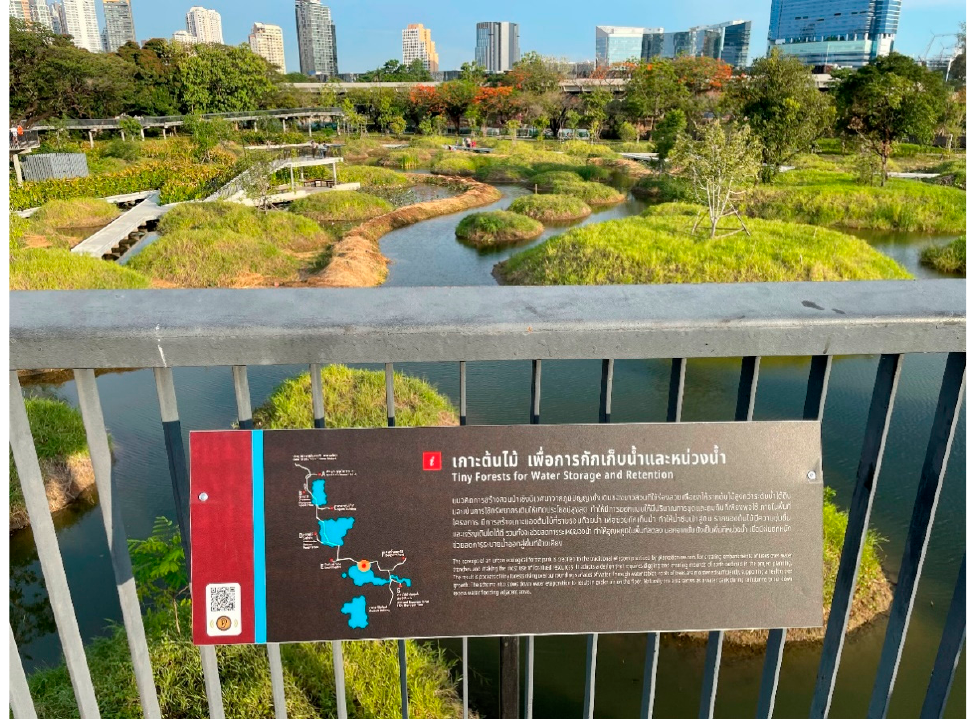
Figure 2. Phase two of the Benjakitti Park development in downtown Bangkok, which opened in December 2021 and presents nature-based water storage and retention opportunities (photo by authors).